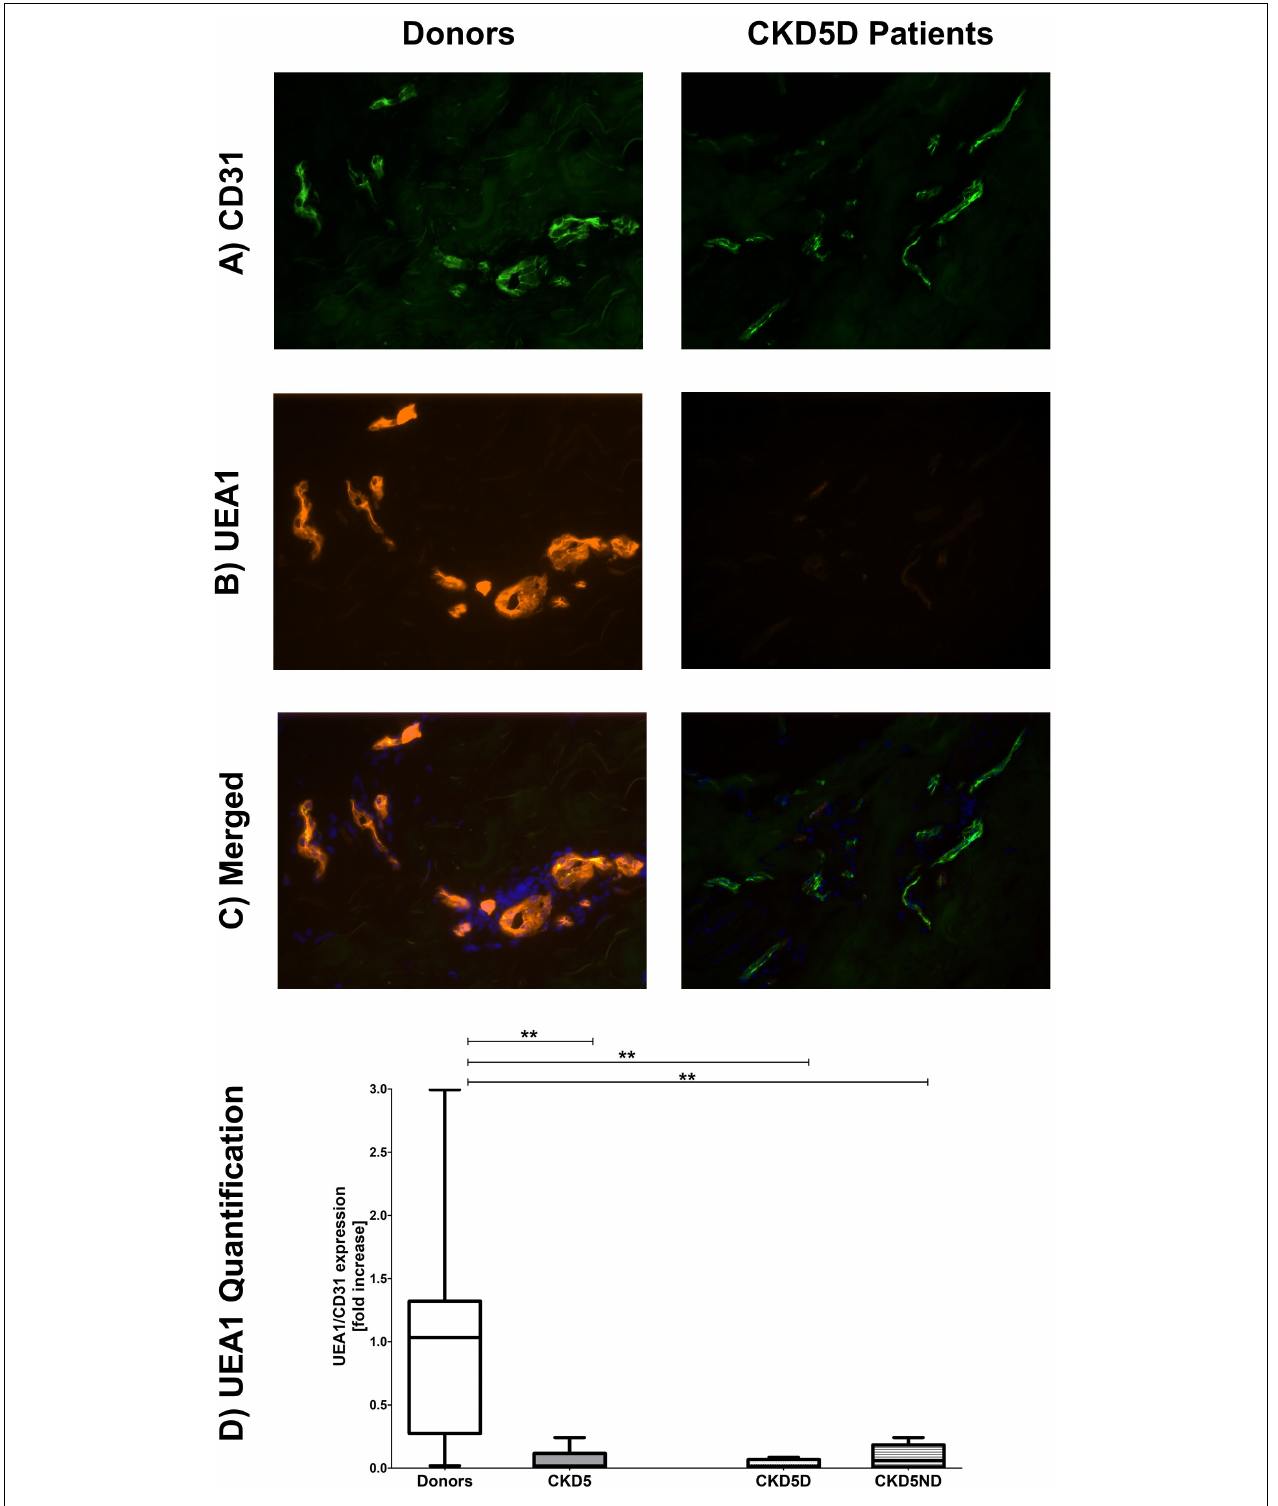
FIGURE 2 | Expression of UEA1 in the microvasculature of dermal biopsies patients with CKD. (A) Expression of CD31 in donors (left image) and CKD5D patients (right image). (B) Expression of UEA1 in donors (left image) and CKD5D patients (right image). (C) Merged expression of UEA1 and CD31 in donors (left image) and CKD5D patients (right image). (D) UEA1 quantification relative to CD31. Colors in images: green = CD31; red = UEA1; blue = DAPI. Statistical significance: ** P < 0.01.